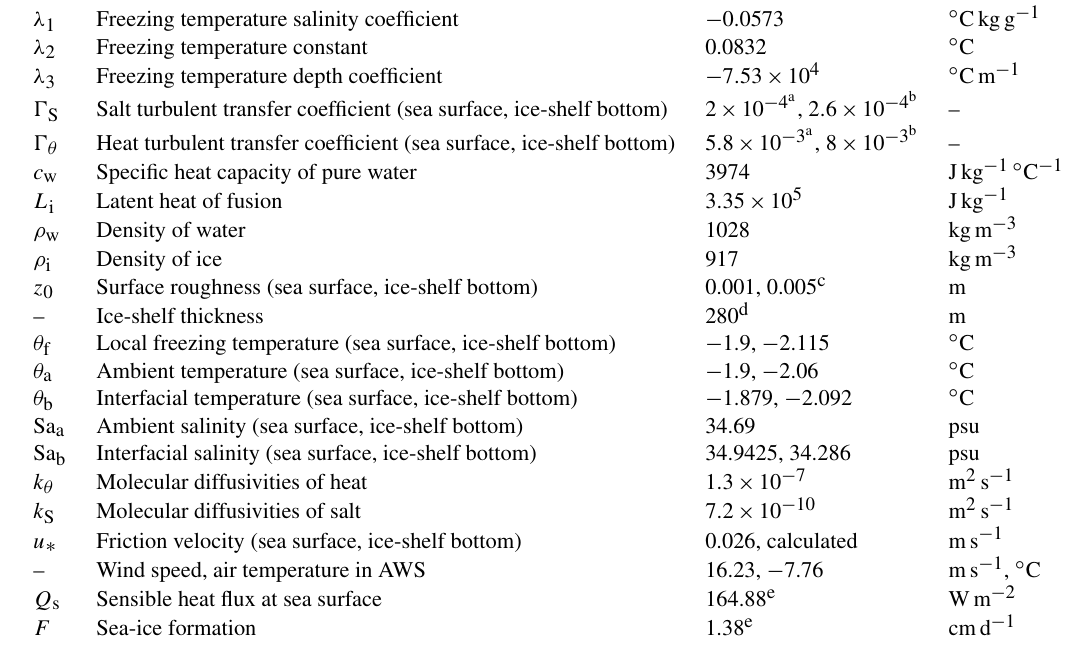
Table 1. List of model parameters and constants.